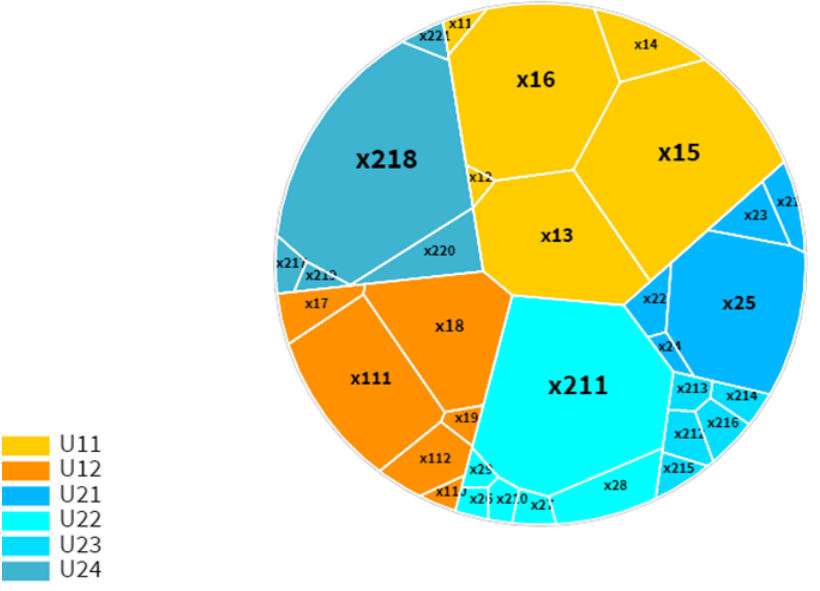
Figure 7. Ranked obstacle factors of Anhui Province’s logistics industry and digital economy.